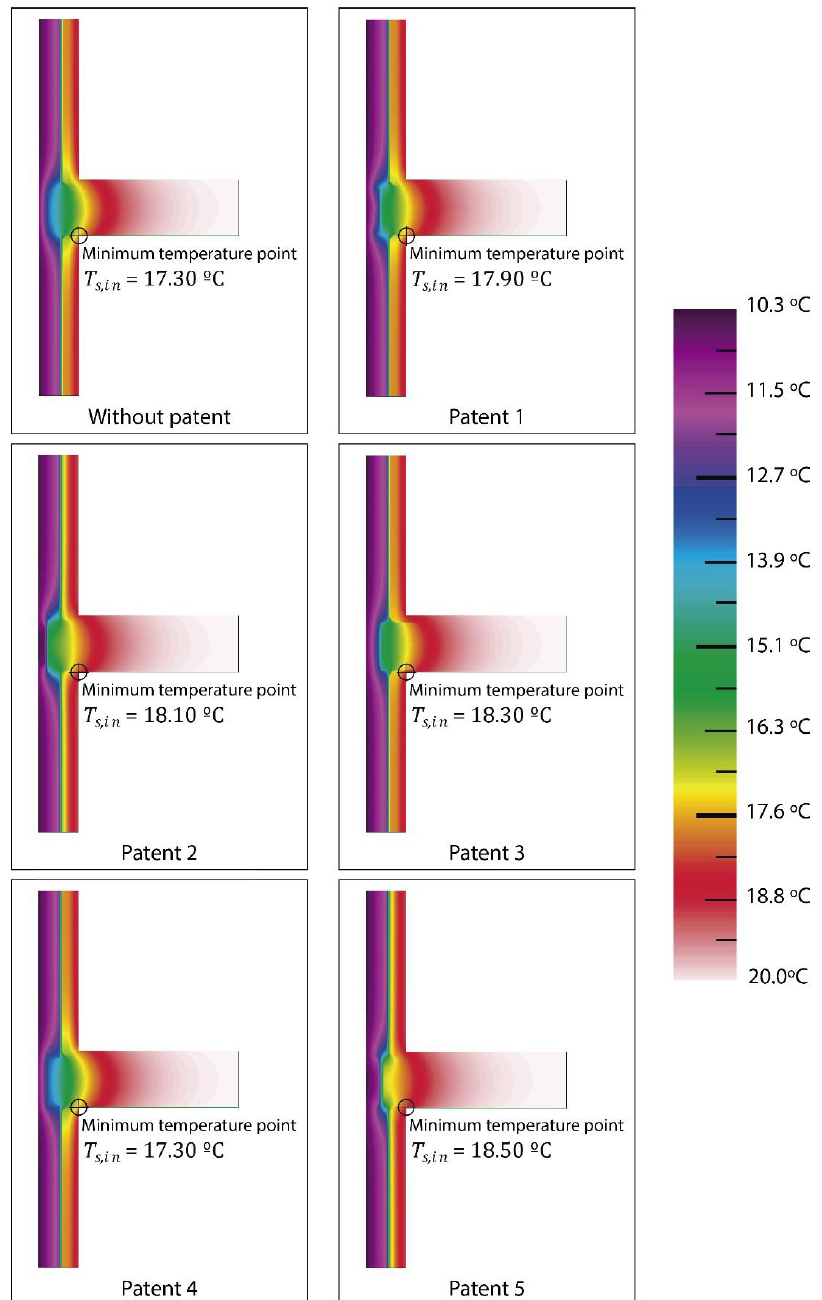
Figure 8. Isotherm profiles for each constructive solution analysed.